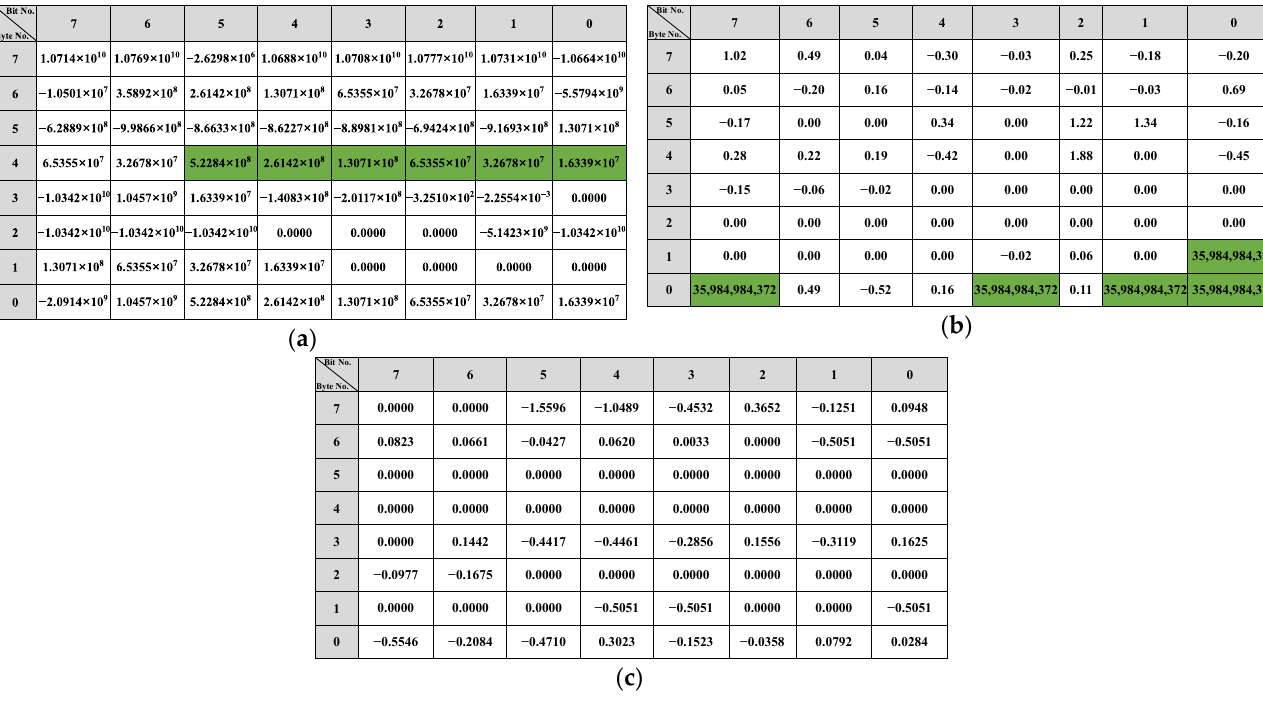
Figure 15. Brake-related messages reverse result: ( a ) ID 0x078 reverse result; ( b ) ID 0x165 reverse result; ( c ) ID 0x202 reverse result.